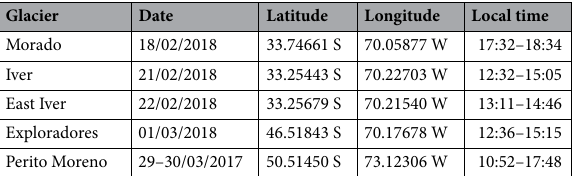
Table 2. Date of sampling of each glacier, coordinates of the approximate centre of the sampling area and (local) time of sampling of the first and last cryoconite